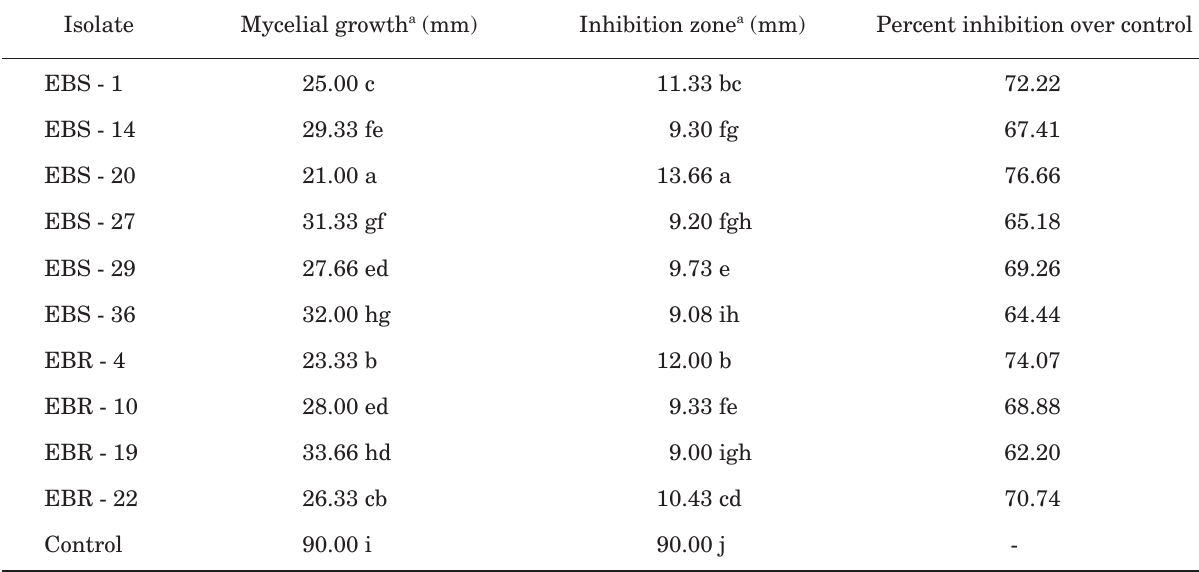
Table 1. In vitro inhibition of mycelial growth of Pythium aphanidermatum by effective endophytes.